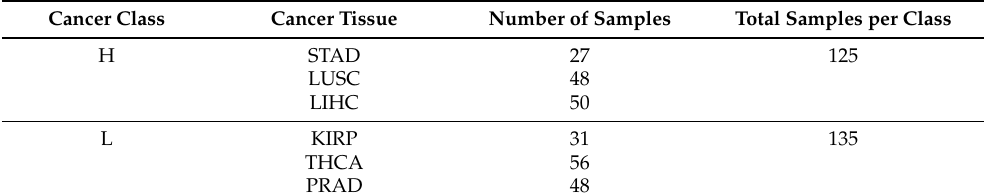
Table 1. Summary of samples analyzed for classes H and L per cancer type.